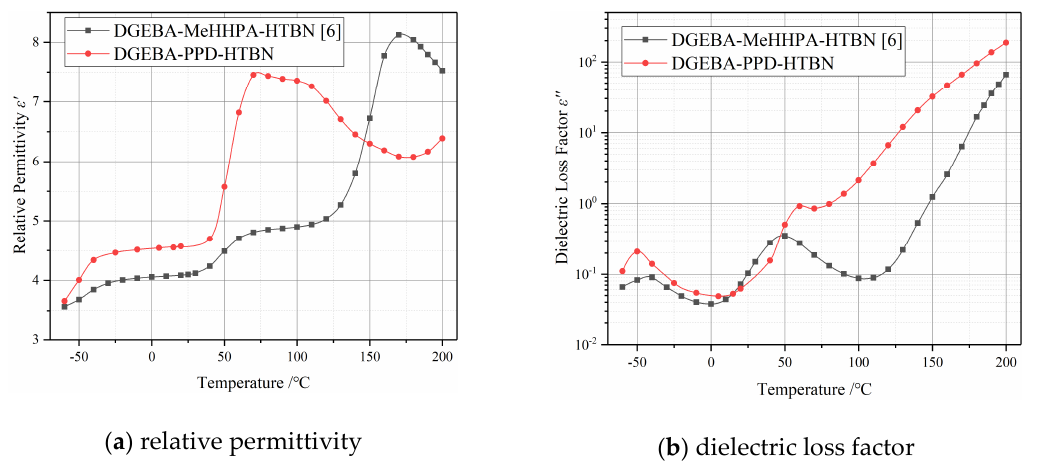
Figure 2. Temperature spectrum characteristics of epoxy resin/liquid rubber composites with different curing agents at 50 Hz: ( a ) relative permittivity; ( b ) dielectric loss factor. DGEBA-MeHHPA-HTBN: the epoxy resin is diglycidyl ether of bisphenol A (DGEBA), the curing agent is methylhexahydrophthalic anhydride(MeHHPA) and the toughening agent is HTBN. The glass transition temperature of DGEBA-MeHHPA-HTBN is 142 °C.